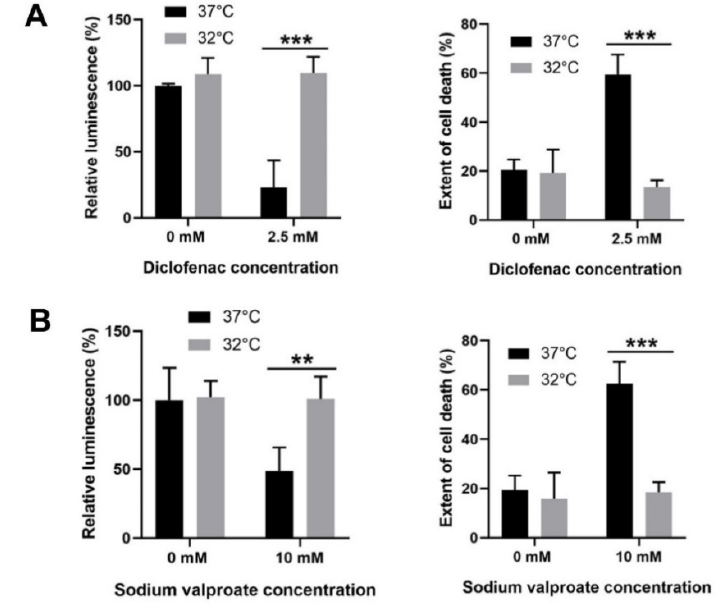
Figure 6. E ff ect of moderate hypothermia (32 ◦ C) on diclofenac- and valproate-induced liver injury. L-02 cells are subjected to concomitant hypothermic conditioning and ( A ) 2.5 mM diclofenac exposure or ( B ) 10 mM sodium valproate exposure for 24 h. Cell viability was examined with cell titer-glo luminescent assay while cell death analysis was determined with propidium iodide staining. Data are presented as mean ± SD ( n = 3), where unpaired t -test was used to compare the e ff ect of hypothermia on L-02 against their respective controls treated with the same drug dose. ** p < 0.01, *** p <